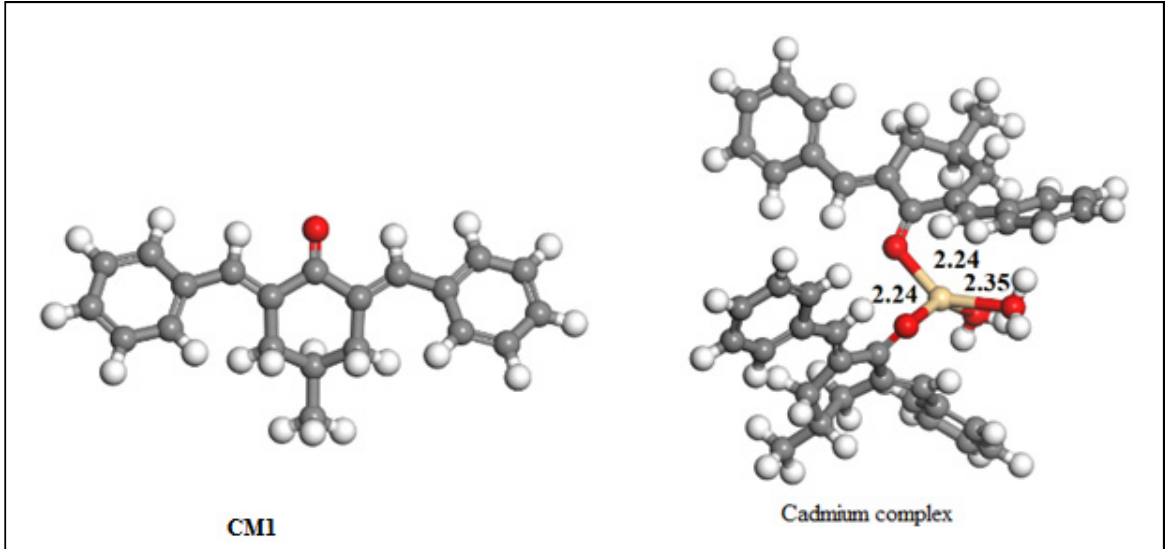
Figure 8. Optimized geometry of the chemosensor CM1 and its cadmium complex. The observed bond length, bond angles, metal–ligand interaction energy, charges on oxygen and cadmium, and highest occupied molecular orbital (HOMO) and lowest unoc- cupied molecular orbital (LUMO) energies of the cadmium complex are listed in Table 2. The observed Cd-O bond lengths with CM1 were 2.24 Å and Cd-O bond lengths with a water value of 2.35 Å. The shorter Cd-O bond lengths with CM1 , as compared to water oxygen, was due to the extensive delocalization of electrons on chemosensor CM1 aromatic rings that made their donor oxygen atom more electron-rich and, hence, caused strong interaction with an electron-deficient metal center. The observed O CM-1 Cd-O CM-1 and O CM-1 -Cd-O water bond angles were 103.08 and 99.24 ◦ , respectively, suggesting a dis- torted tetrahedral complex. The tetrahedral geometry of the complex could also be ex- plained based on orbital hybridization and their involvement in bond formation, since, in Cd 2+ , all the d orbitals are fi lled (d 10 system). Therefore, no orbital in the “d” subshell was subshells underwent sp 3 hybridization and, consequently, formed tetrahedral structures.